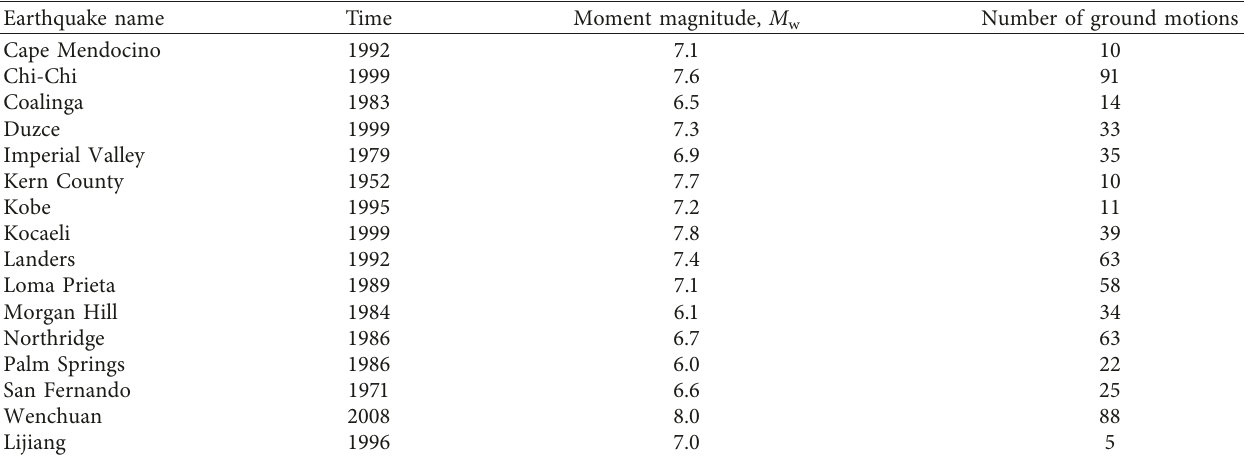
Table 1: Selected ground motions in this study.